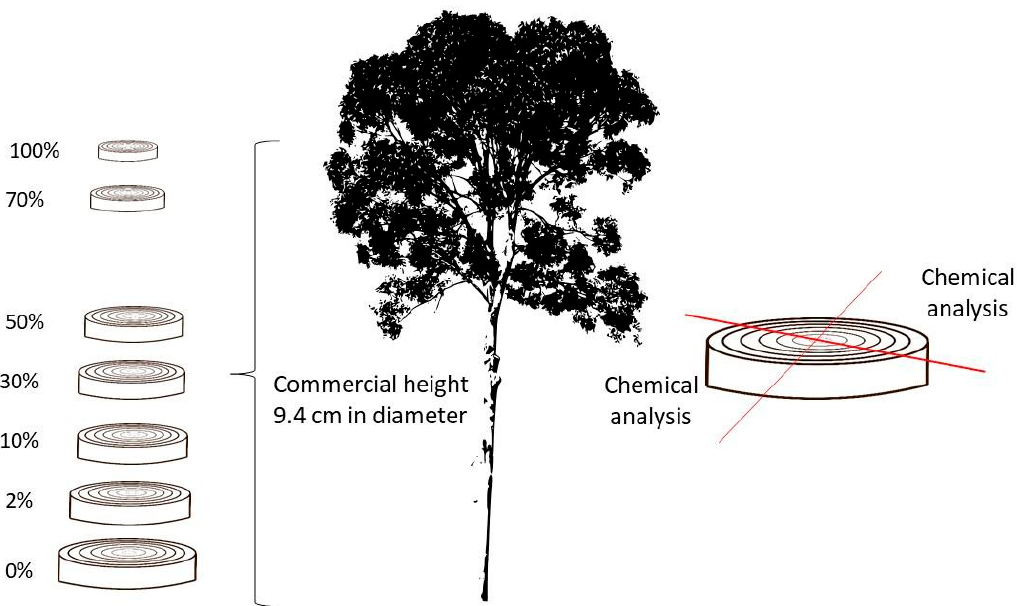
Figure 1. Removal of wood sample discs from different axial positions (at 0%, 2%, 10%, 30%, 50%, 70% and 100% of the commercial height) of the Eucalyptus trees for chemical characterization.